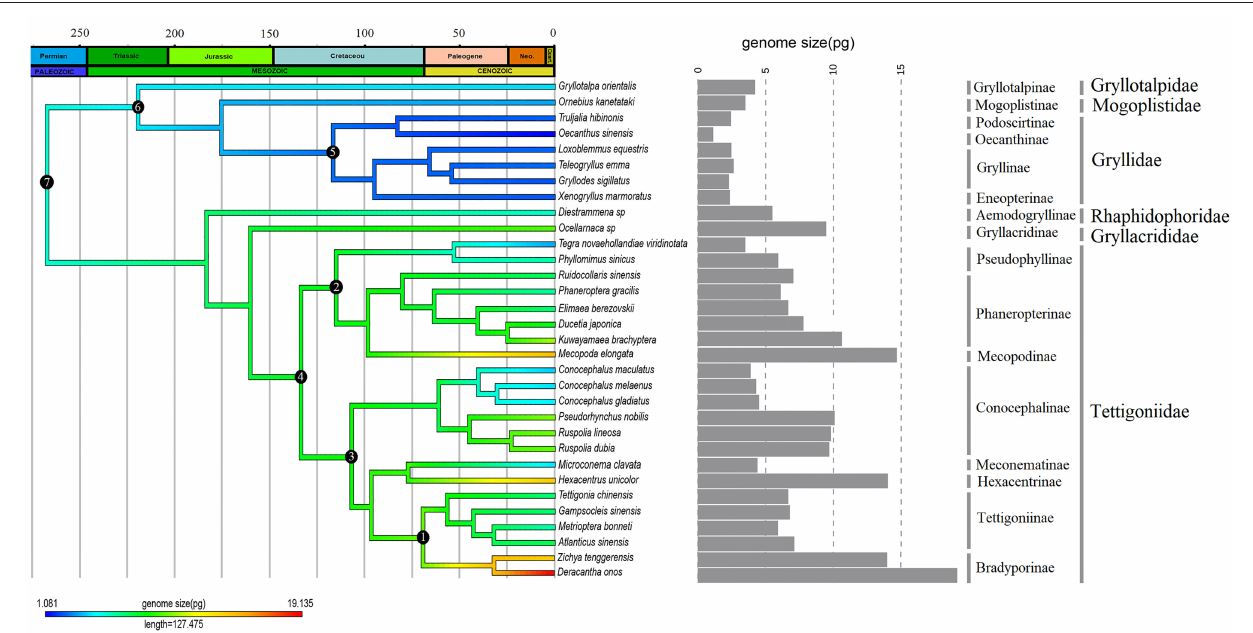
FIGURE 3 | Ancestral reconstruction of the genome size of (female) Ensifera based on a time-calibrated phylogenetic tree. The black circles with numbers on the nodes correspond to the estimated ancestral genome size using fastAnc, BayesTrait, and Mesquite in Table 2 . The average genome size of each species is shown in a histogram on the